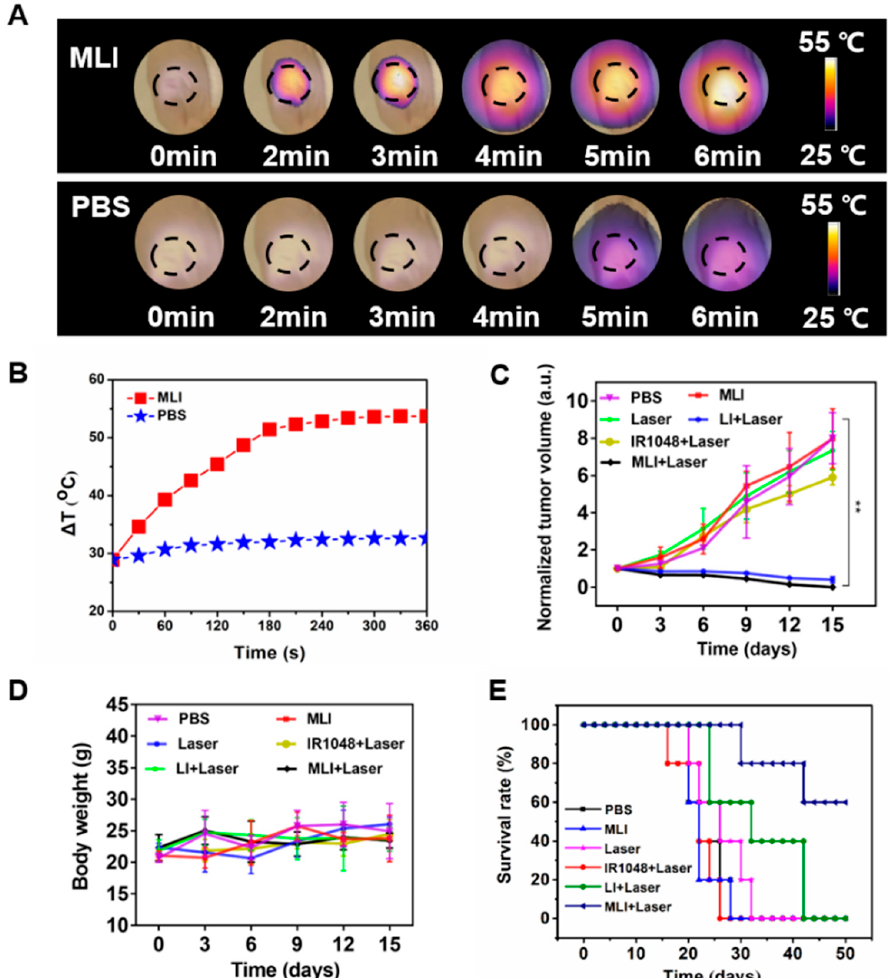
Figure 5. Thermal recording and anti-cancer evaluation of MLI. ( A ) In vivo photothermal images of tumors after intravenous injection of MLI and PBS upon 1064 nm laser excitation. ( B ) Temperature profiles of tumor site after tail-vein injection of MLI and PBS. ( C ) Normalized tumor volume variations. ( D ) Body weight variations of different treatment groups. ( E ) Mice survival curves for various treatment groups. ** p < 0.01.